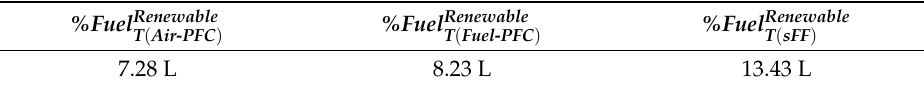
Figure 15. Oxygen excess ratio. 4. Discussion The results were comparatively analyzed in section of the results for the FC system and the FC/renewable HPS using the strategies sFF, air-PFC, fuel-PFC, and air/fuel-PFC; here, we summarize and discuss these further in the frame of the working hypotheses.